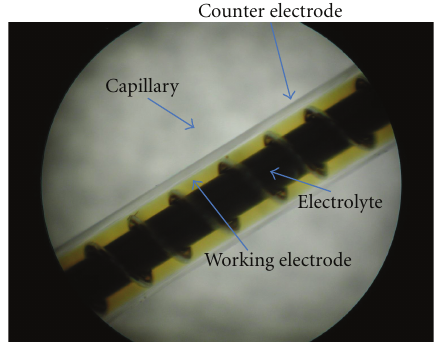
Figure 1: An optical photo of FDSSC structure